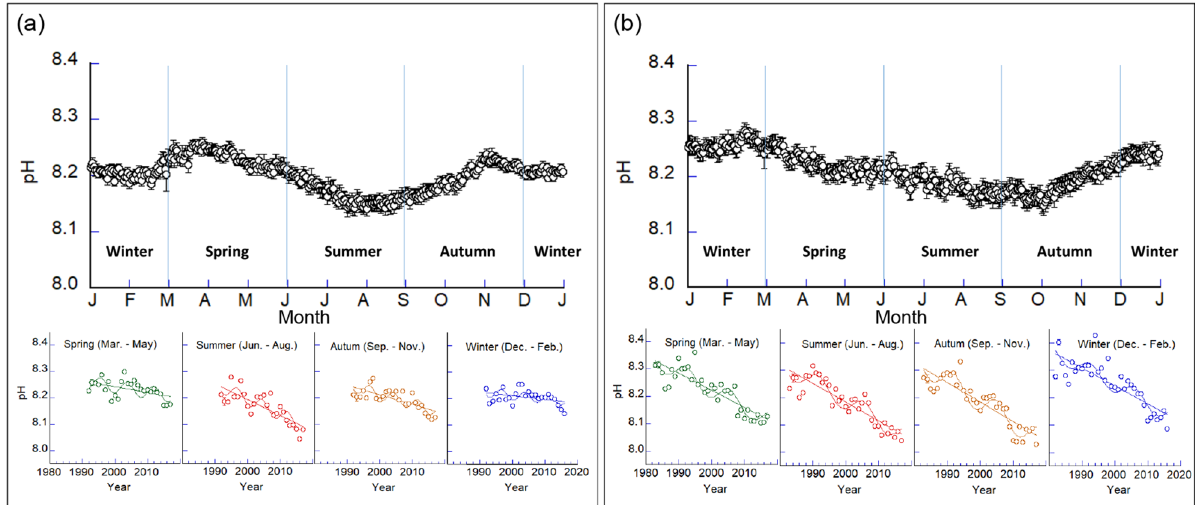
Figure 4. Seasonal variations and long-term trends in the pH by season for the coastal region of the Sea of Japan and North Pacific. The Demonstration Laboratory (DL) on the coast of the Sea of Japan (a) and Central Laboratory (CL) on the coast of the Pacific Ocean (b) . The upper figure shows daily averaged values, where the error bars represent the standard errors. The lower figure shows the long-term trends in the oceanic pH by season. Straight lines show linear trends while sine curves show decadal oscillations. Table 1 summarizes the trend slopes, acidification rates, statistical p -values, and correlation